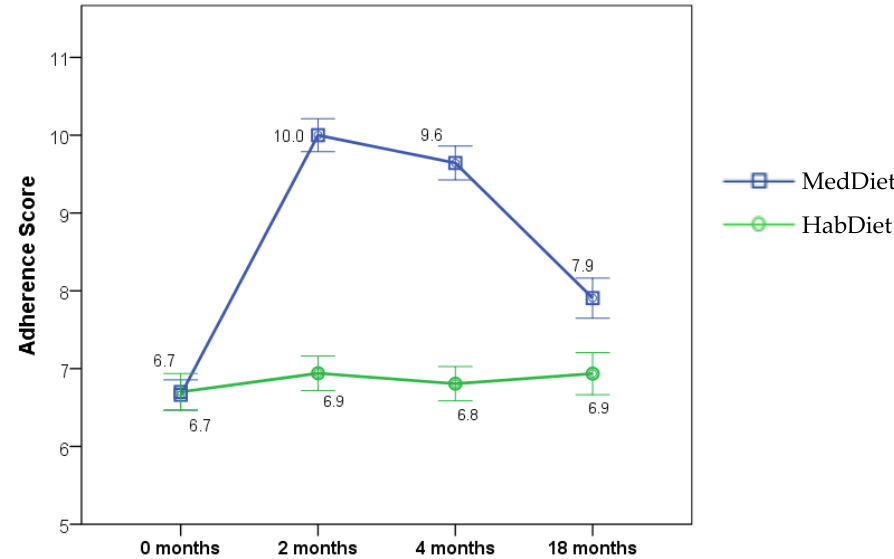
Figure 2. Mediterranean Diet Adherence Score at baseline (0 months) and during 6 months dietary intervention (measured at 2 and 4 months) and 12 months after intervention was ceased (18 months) for MedDiet or HabDiet. Adherence score (mean ± SEM) at each time point by diet group. MedDiet adherence score based on intakes of 15 food groups calculated from food frequency questionnaires, range 0–15, where 15 represents highest possible adherence level. Linear mixed effects model with a group × time interaction term. Analyses were intention to treat. MedDiet: n = 77, 70, 70, 66, at 0, 2, 4 and 18-months, respectively; HabDiet: n = 70, 67, 67, 62 at 0, 2, 4, and 18 months, respectively. MedDiet, Mediterranean diet; HabDiet, habitual